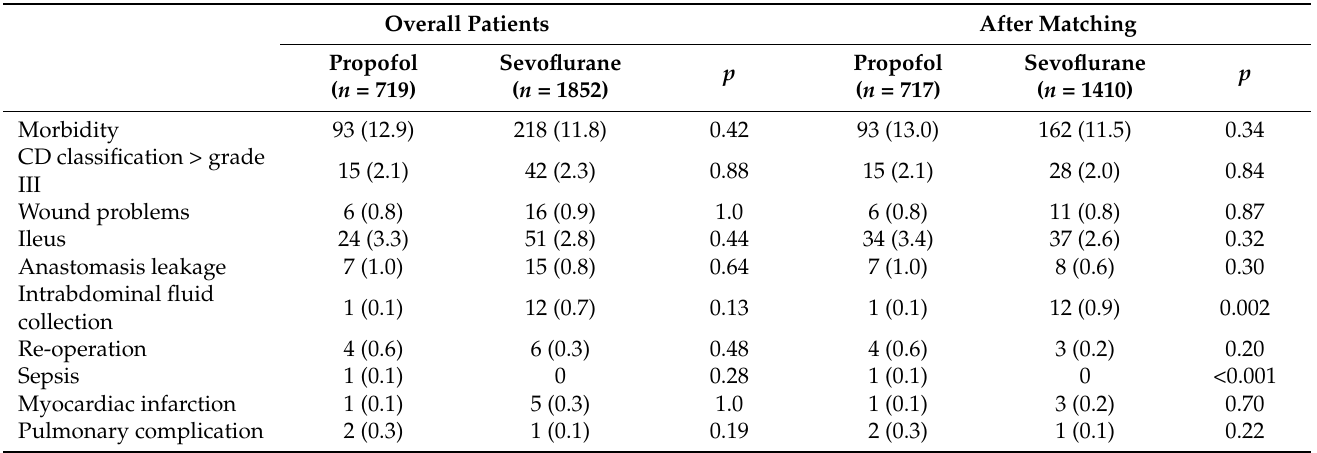
Table 2. Comparison of early postoperative complications with propofol- and sevoflurane-based anesthesia before and after propensity score